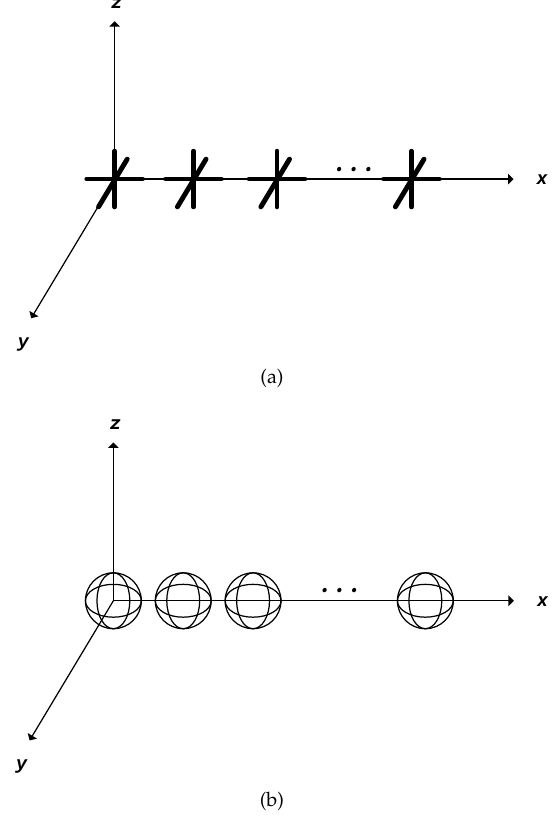
Figure 1. ( a ) Three orthogonally-oriented dipoles; ( b ) Three orthogonally-oriented